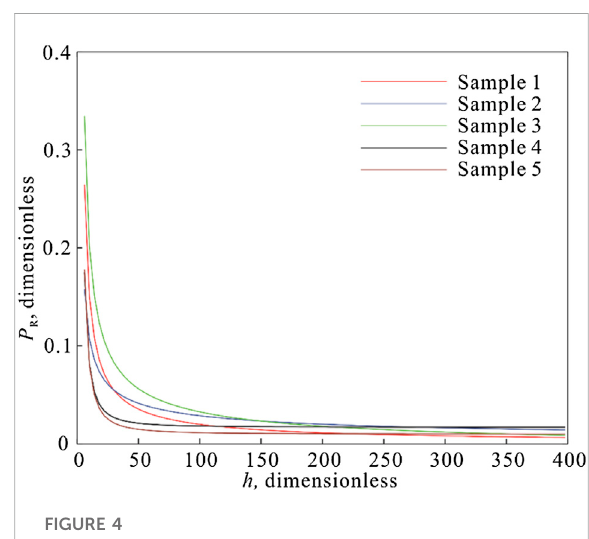
FIGURE 4 The magnitude of Pearson coef fi cient of core